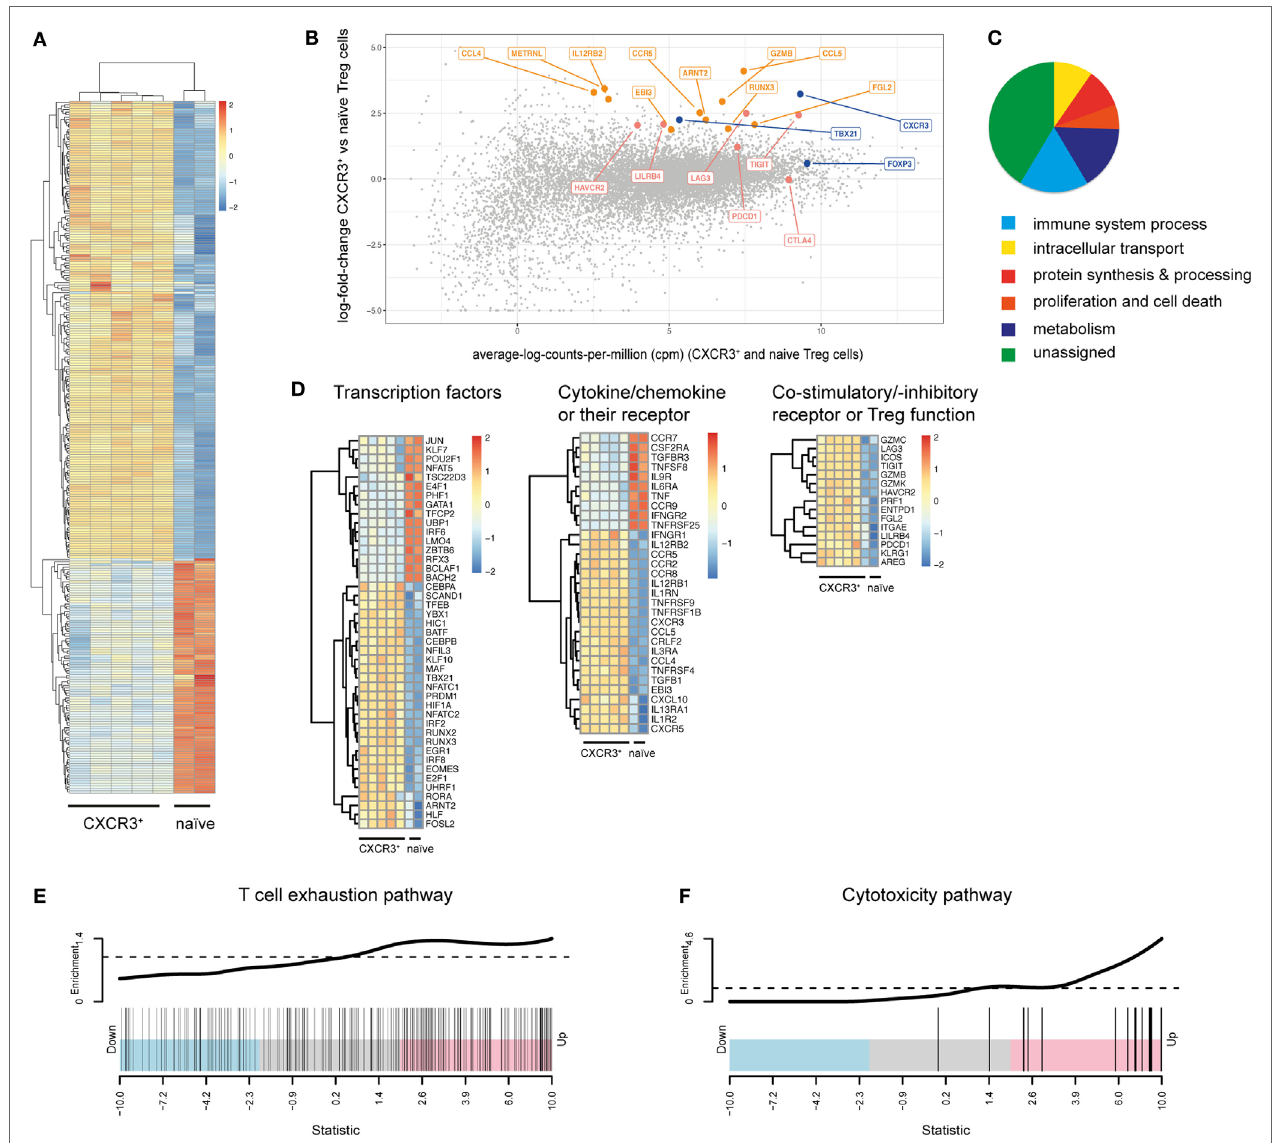
FigUre 2 | CXCR3 + Treg cells show a distinct transcriptional profile. (a–D) Transcriptional profiling of CD4 + Foxp3 + CXCR3 + Treg cells from day 14 LCMV-infected mice and naïve CD4 + Foxp3 + Treg cells sorted from pooled spleen and LNs of Foxp3 -GFP reporter mice was performed using RNA-seq analysis. (a) Heat map of differentially expressed immune genes (log2 FC > 1, log2 cpm > 2). (B) Differential gene expression between CXCR3 + and naïve Treg cells. Control genes (blue), co-inhibitory receptor genes (red), and other immune genes (orange) are highlighted. (c) Pie-chart of differentially expressed genes (log2 FC > 1, log2 cpm > 2) assigned to the stated GO slim terms. (D) Heat map of transcription factor, chemokine (receptor) and cytokine (receptor), and Treg function related genes that are differentially expressed (log2 FC > 1, log2 cpm > 2) in CXCR3 + versus naïve Treg cells. (e,F) “Barcode” plots of changes in expression (CXCR3 + versus naïve Treg cells) in the context of T cell exhaustion (e) and cytotoxicity (F) pathways. Genes are ordered by Z -score (using p -values from the edgeR differential expression analysis, signed by the direction of change) and the genes within the pathway are shown with vertical black bars. The top line shows the relative enrichment of the vertical